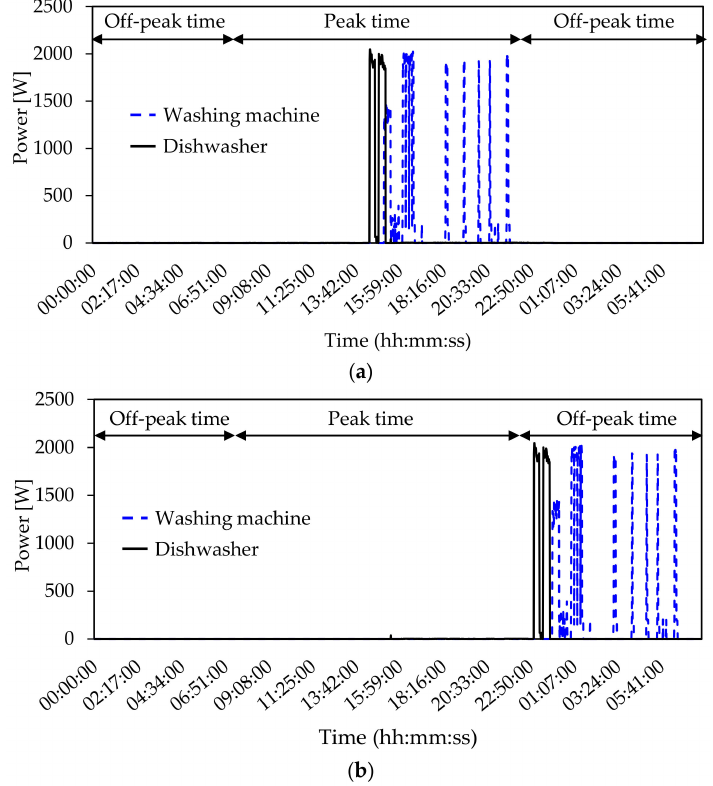
Figure 19. Example of electricity management of 2 electrical devices: real power demand (from measurements) ( a ). Power demand after a smart control of the loads ( b